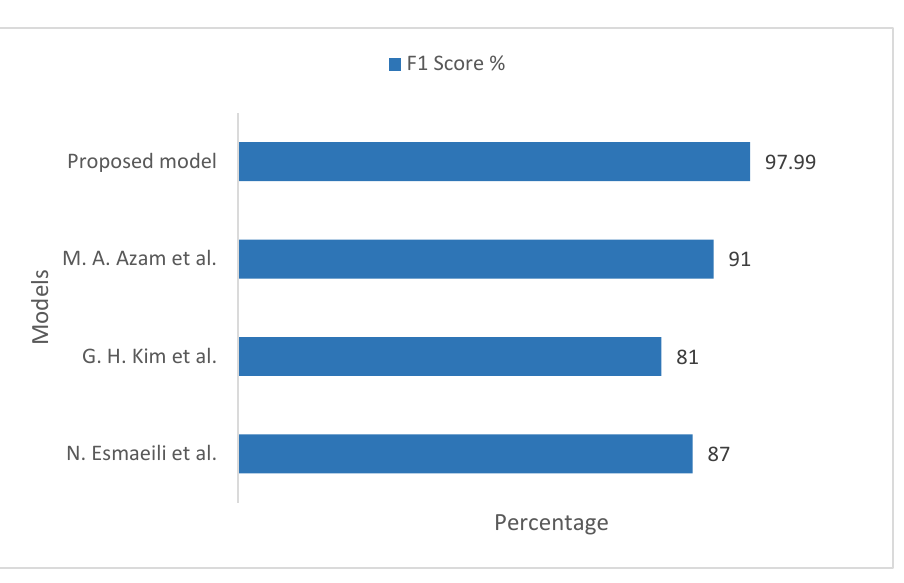
Figure 9. Comparison of F1 score between the proposed model and the existing models, taking into account the ImageNet datasets [33–35].